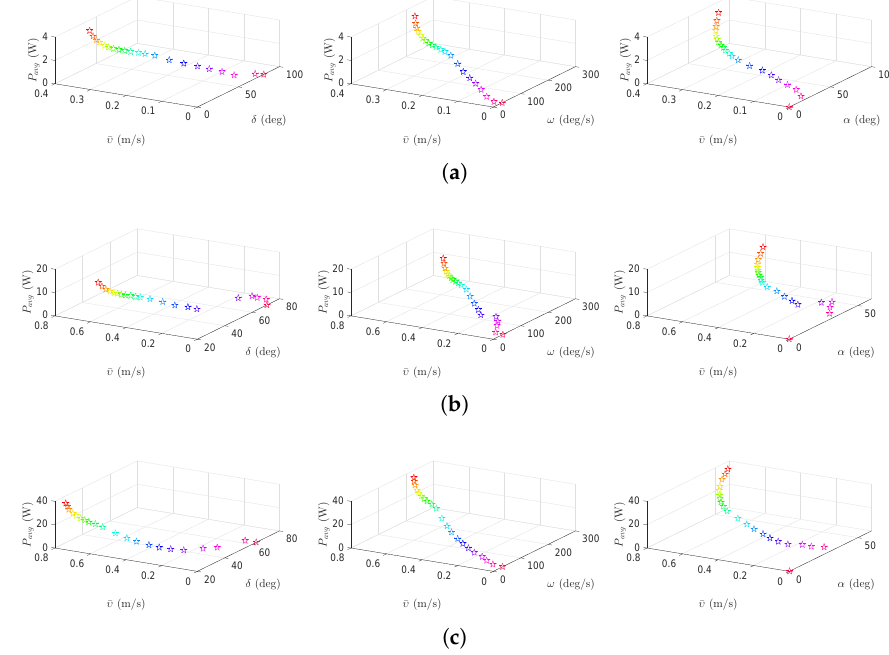
Figure 9. Optimal gait parameters for the eel-like motion pattern for the USR, without considering the negative work effect: ( a ) 3D plots of optimal gait parameters for robot with n = 5 links; ( b ) 3D plots of optimal gait parameters for robot with n = 10 links; and ( c ) 3D plots of optimal gait parameters for robot with n = 20 links. Colors illustrate different weights of the objective functions. Table 3. Multi-objective optimization results for the lateral undulation motion pattern for the USR with different numbers of links, considering the negative work effect.